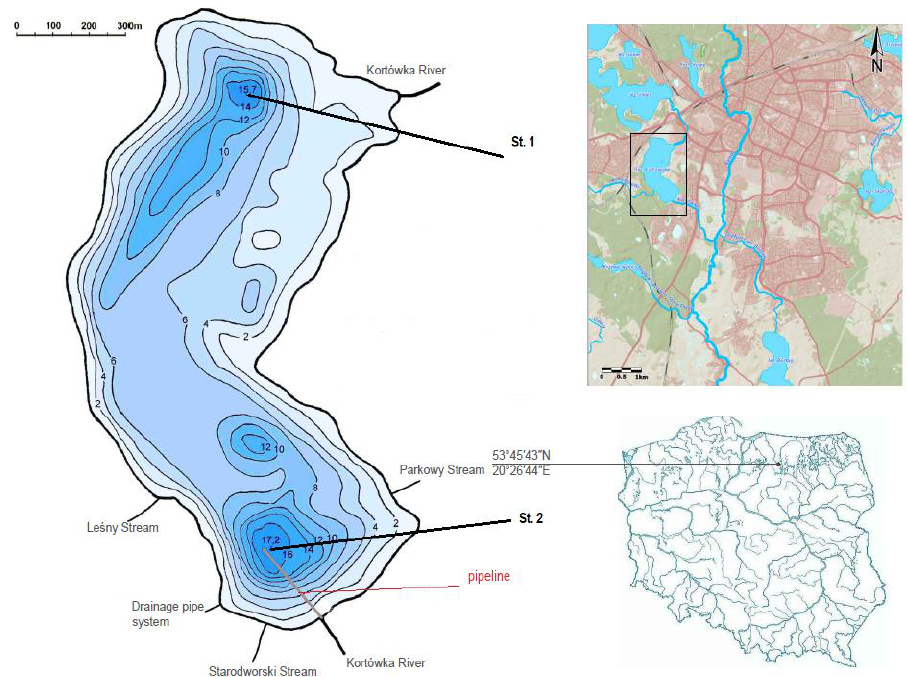
Figure 2. Bathymetric map of Lake Kortowskie with the location of sampling stations [19] (modified).